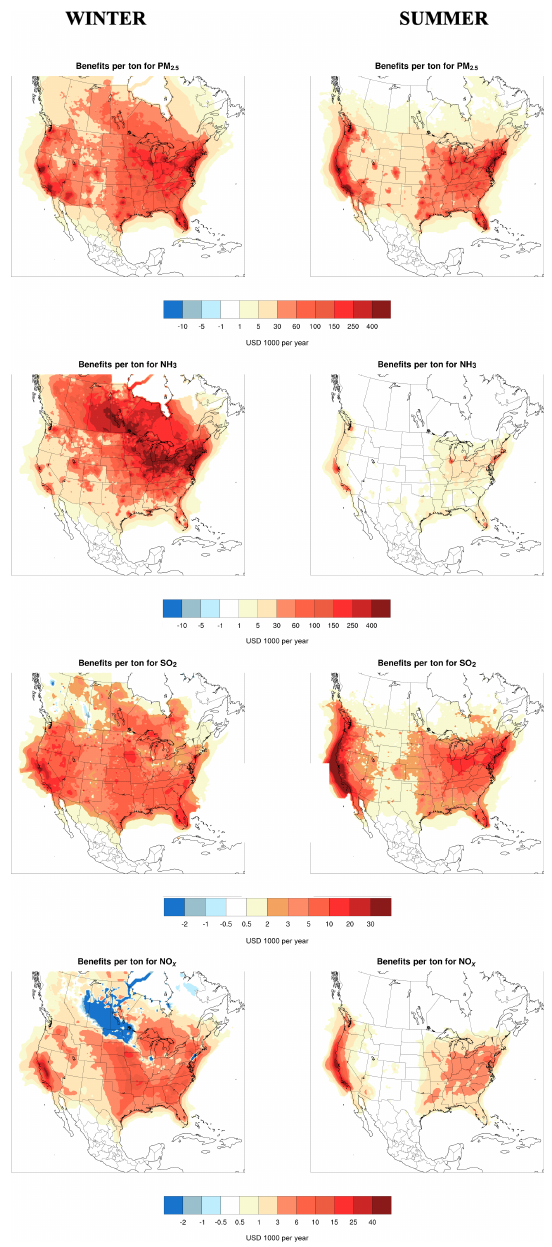
Figure 14. Application of the adjoint model for adjoint sensitiv- ity analysis to estimate the benefits per ton (BPTs) related to long- term PM 2 . 5 exposure for primary PM 2 . 5 emissions in the US and its precursors NH 3 , SO 2 , and NO x . The BPT is time-integrated and location-specific; i.e., each value in the figures represents the BPT for the specific emissions at the specific location. For exam- ple, a value of USD30000 per ton for SO 2 emissions at a loca- tion suggests that reducing emissions of SO 2 at that location entails USD30000 in valuated benefits across the US. The left and right columns show BPTs from 3-month simulations for winter and sum- mer,